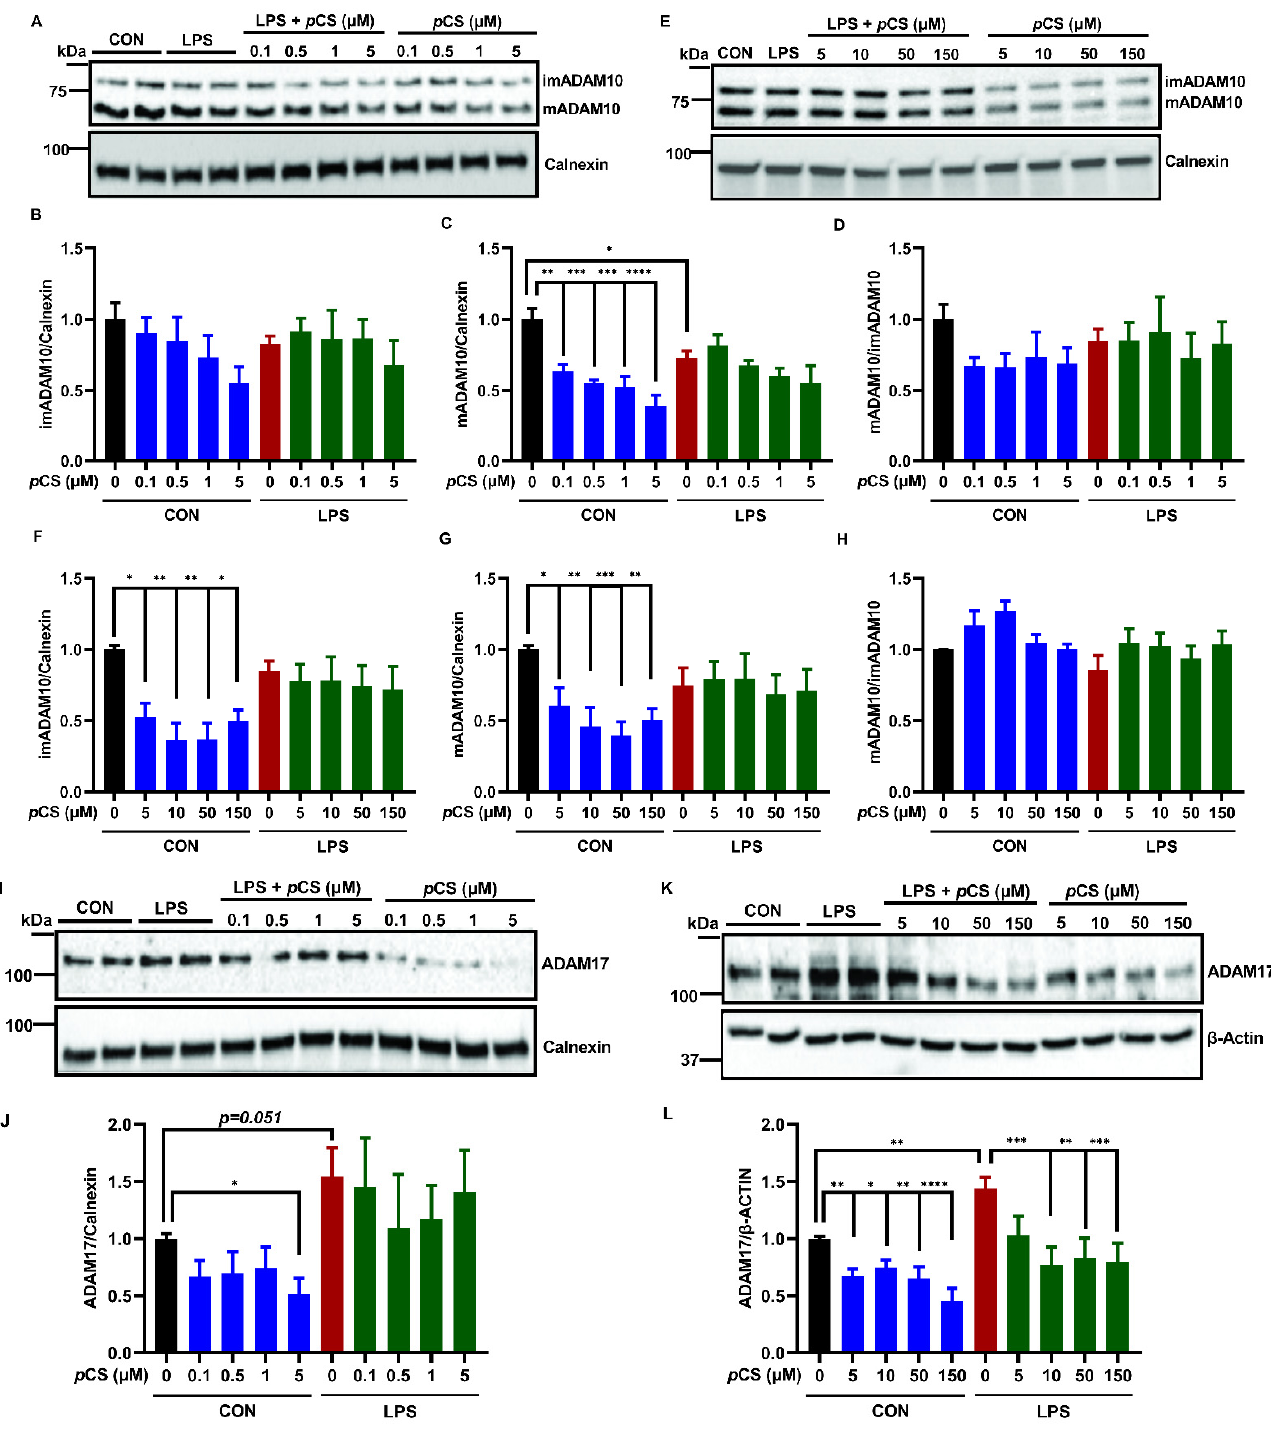
Figure 1. Effect of p CS on ADAM10 and ADAM17 expression of constitutive and LPS-activated BV2 microglial cells. BV2 microglia were incubated with p CS for 24 h in the absence or presence of 1000 ng/mL LPS. Cell lysate was collected for WB analysis. ( A ) The representative immunoblots of ADAM10 protein expression with low concentration range of p CS. ( B – D ) The quantification results of immature ADAM10 (imADAM10), and mature ADAM10 (mADAM10) and maturation efficiency (ratio mADAM10/imADAM10) of BV2 cells exposed to a low concentration range of p CS ( n = 4 independent experiments). ( E ) The representative immunoblots of ADAM10 protein expression with a high concentration range of p CS. ( F – H ) The quantification results of ADAM10 protein expression of BV2 cells exposed to a high concentration range of p CS treatment ( n = 5 independent experi- ments). ( I ) The representative immunoblots of ADAM17 protein expression with low concentration range of p CS. ( J ) The quantification results of ADAM17 protein expression with low concentration range of p CS ( n = 4 independent experiments). ( K ) The representative immunoblots of ADAM17 protein expression with a high concentration range of p CS. ( L ) The quantification results of ADAM17 protein expression with a high concentration range of p CS ( n = 6 independent experi- ments). Calnexin or β -Actin were used as a loading controls. Black: constitutive protein expression set at 1; red: LPS-induced protein expression; blue: effect of p CS on constitutive protein expression; green: effect of p CS on LPS-induced protein expression. Results were expressed as mean ± SEM. * p < 0.05, ** p < 0.01, *** p < 0.001 , **** p < 0.0001. 2.2. ADAM10 and ADAM17 Cleave TNF- α , TNFR-1 and IL-6R from BV2 Microglia The role of ADAM10 and ADAM17 is not known in the release of TNF- α and IL-6 as wells as the cleavages of TNFR-1 and IL-6R from BV2 microglial cells during an innate immune response. To this end, we employed the effects of GI254023X, a selective and po- tent inhibitor of ADAM10 activity [55,56], and TAPI-1, a compound preferential inhibiting ADAM17, followed by other metalloproteinases [57,58] on constitutive and LPS-activated BV2 cells. A 24 h incubation with LPS resulted in a significant release of TNF- α , IL-6 and TNFR-1 compared to vehicle treated BV2 cells, whereas LPS did not affect sIL-6R levels (Figure 2A–D). Both ADAM10 inhibitor, GI254023X (5 μ M), and ADAM17 inhibitor, TAPI-1 (25 μ M) significantly decreased the constitutive and LPS-induced release of TNF- α and soluble TNFR-1 (sTNFR-1), indicating either ADAM10 or ADAM17 (and possibly other metalloproteases) regulate the cleavages of TNF- α and TNFR-1 in BV2 microglia (Figure 2A,B). GI254023X did not affect the LPS-induced release of IL-6 from BV2 cells, and TAPI-1 significantly enhanced the release of IL-6 (Figure 2C). In contrast, GI254023X and TAPI-1 did inhibit the release of soluble IL-6R (sIL-6R), indicating ADAM10 and ADAM17 control the cleavage of IL-6R (Figure 2D).